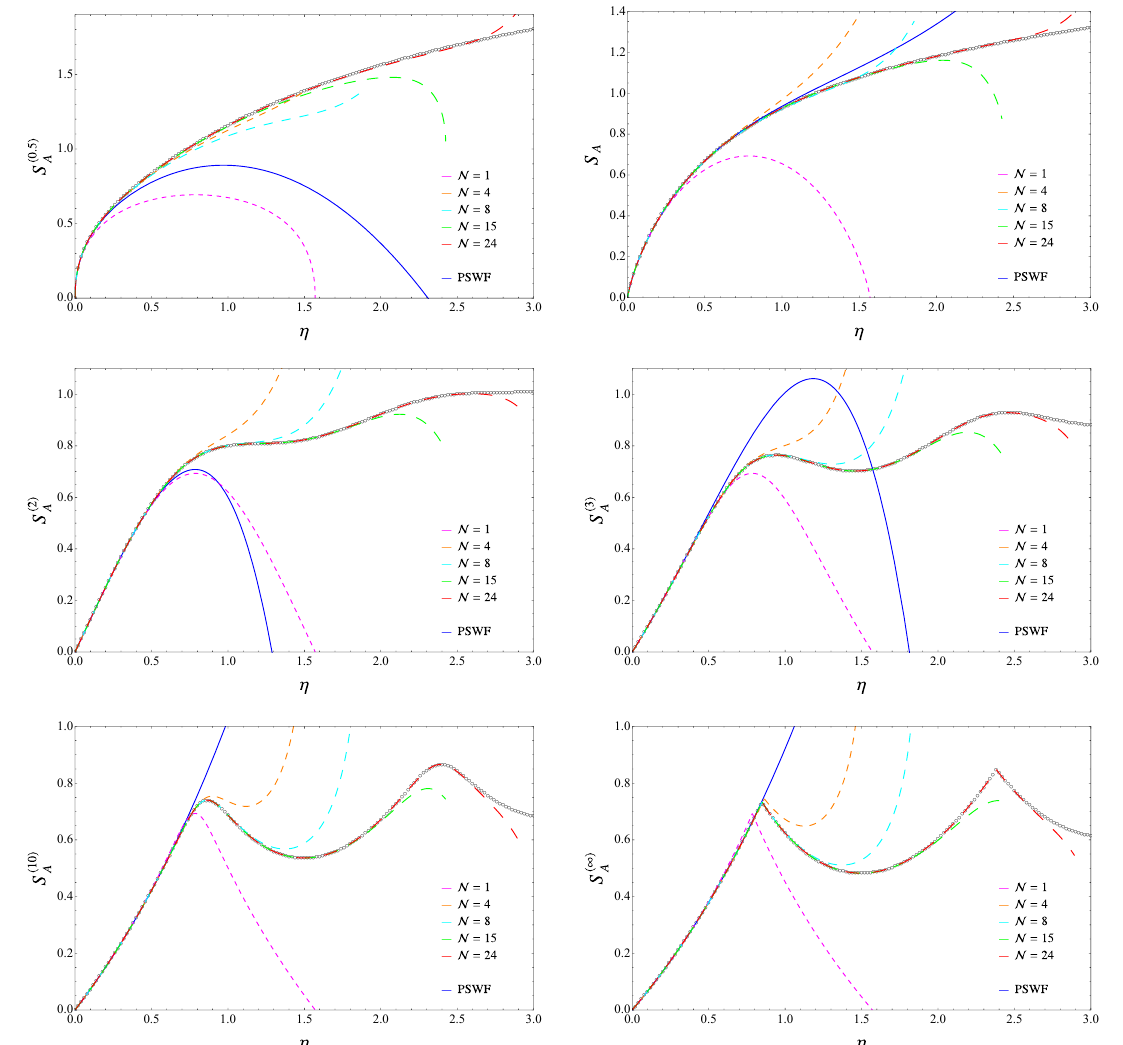
Figure 7. Entanglement entropies S ( α ) in the small η regime. Different values of α are considered A in the different panels. The numerical results correspond to the black empty markers and the coloured curves to the analytic approximate expressions as follows: the dashed curves are obtained from (7.3) for increasing values of N (see section 7.1) and the solid blue lines from (7.8), (7.12) and (7.14) (see section